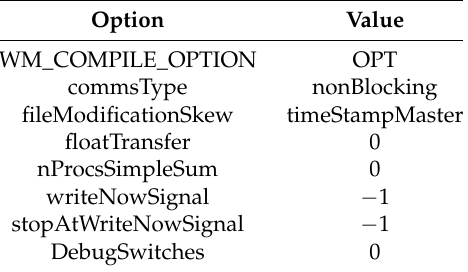
Table 6. Configuration of